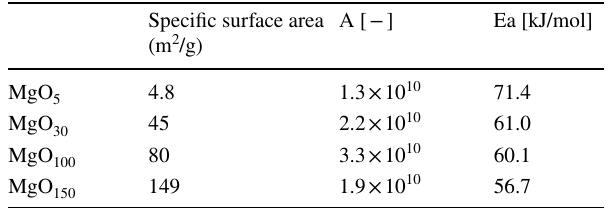
Table 6 Apparent activation energy and the frequency factor of this